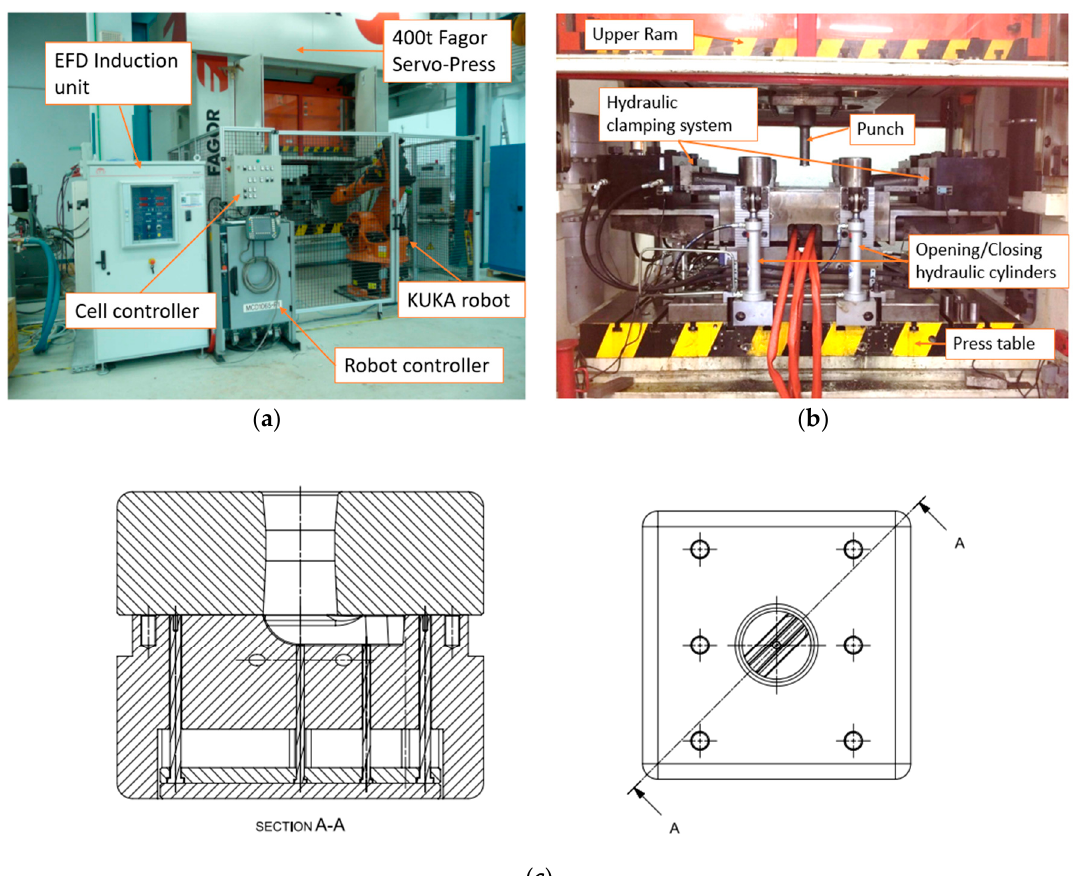
Figure 2. ( a ) The NSF cell of Mondragon University, ( b ) the self-designed NSF tooling for high melting point alloys [17] and ( c ) schematic drawing of the dies and expulsion system.